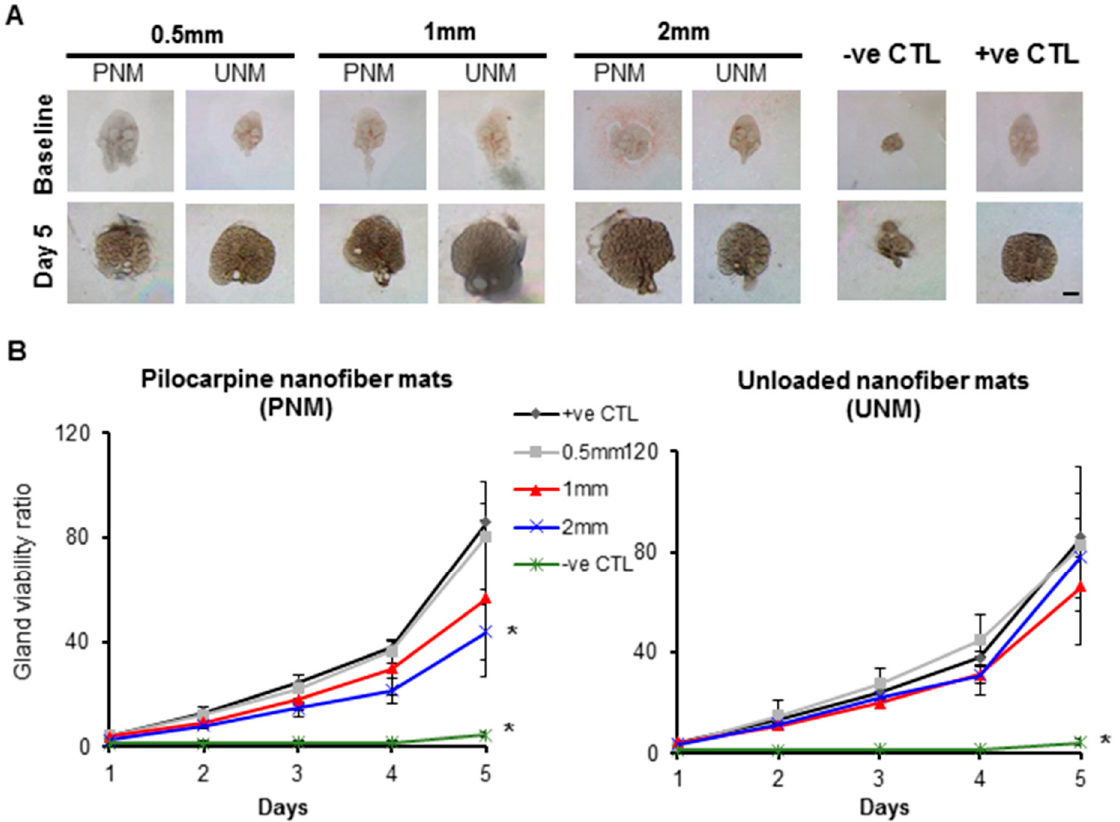
Figure 3. Biocompatibility of pilocarpine ‐ loaded and unloaded nanofiber mats (PNM and UNM, respectively) in the ex vivo SG culture model. ( A ) Bright field images of the growing SG glands at